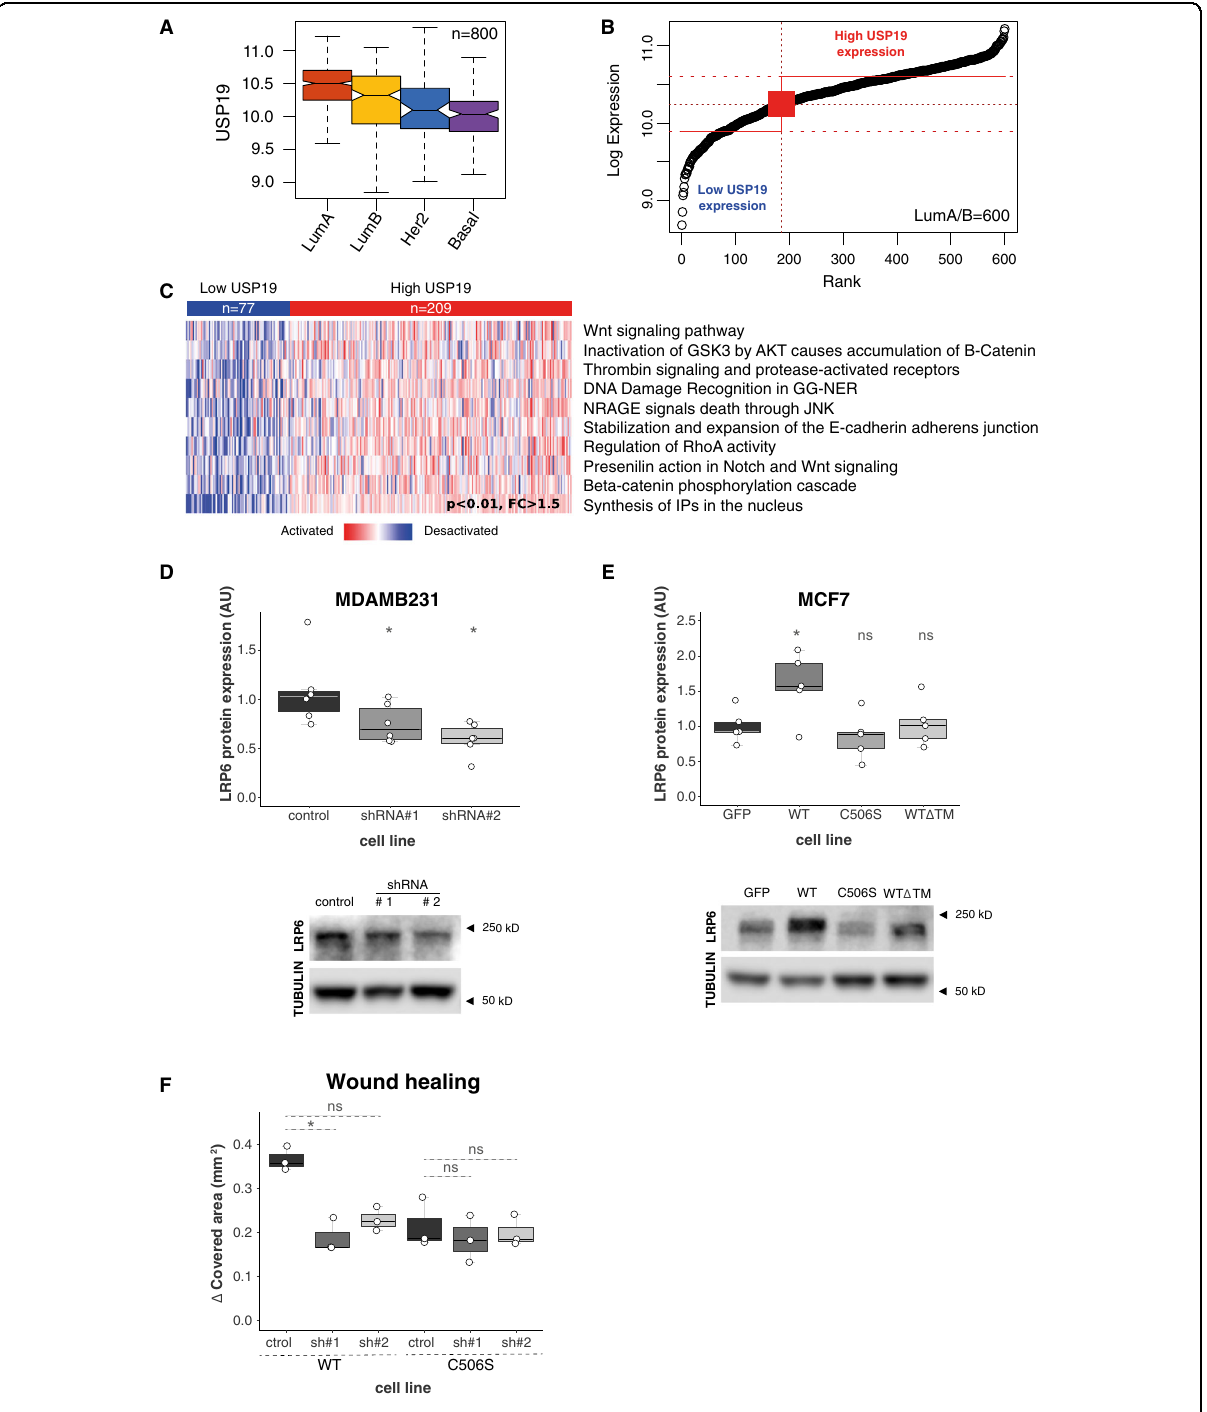
Wnt signaling pathway Inactivation of GSK3 by AKT causes accumulation of B-Catenin Thrombin signaling and protease-activated receptors DNA Damage Recognition in GG-NER NRAGE signals death through JNK Stabilization and expansion of the E-cadherin adherens junction Regulation of RhoA activity Presenilin action in Notch and Wnt signaling Beta-catenin phosphorylation cascade Synthesis of IPs in the